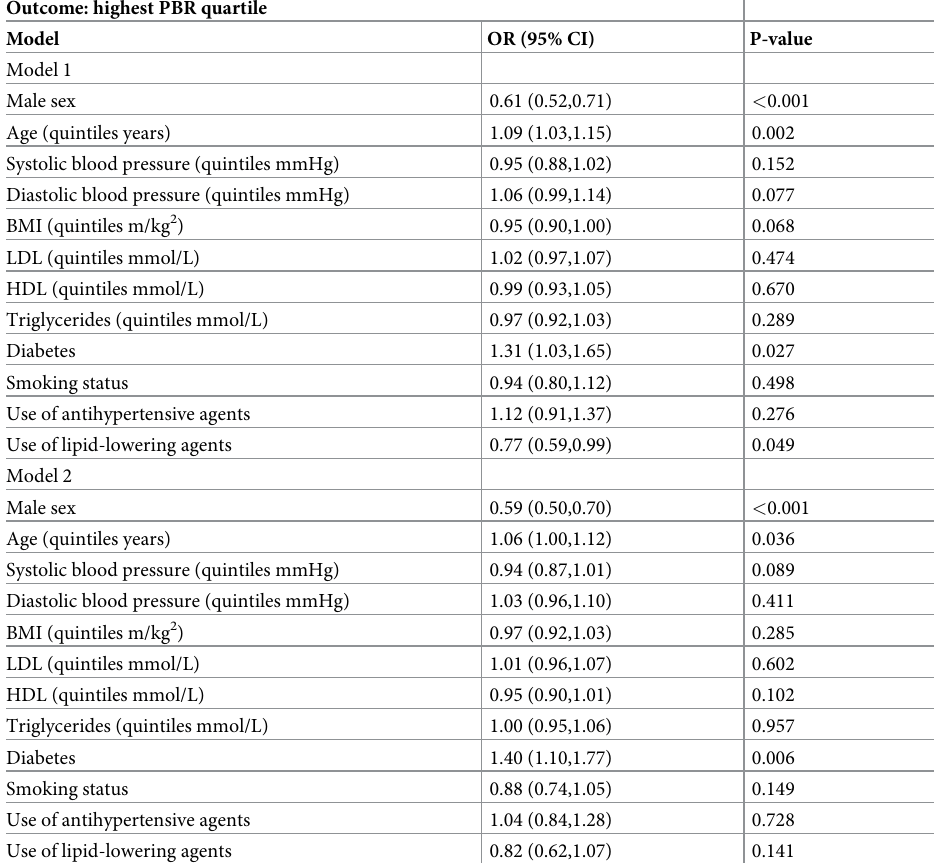
Table 2. Multivariate logistic regression analysis of the association between cardiovascular risk factors and high- est PBR quartile (smallest glycocalyx size). Outcome: highest PBR quartile